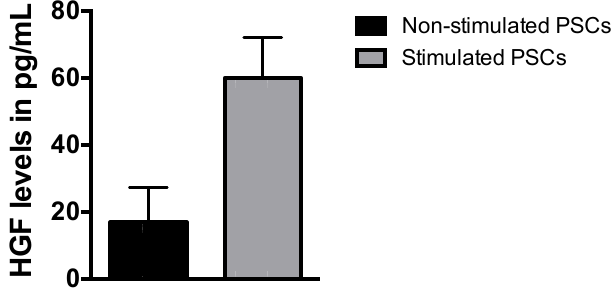
Figure 2. Measurement of HGF levels in medium of (non-)stimulated PSCs. HGF levels (in pg / mL) were measured by ELISA in PSC media, that were previously stimulated with(out) the conditioned medium of primary PDAC5 cells sorted SSEA4 (PDAC5 (SSEA4)) for 3 days. The values shown in the bar chart represent the mean ± standard error of mean (S.E.M.) of at least three experiments. Abbreviations: HGF, hepatocyte growth factor; PSCs, pancreatic stellate cells; ELISA, enzyme-linked immunosorbent assay; PDAC, pancreatic ductal adenocarcinoma; SSEA4, stage specific embryonic antigen-4.